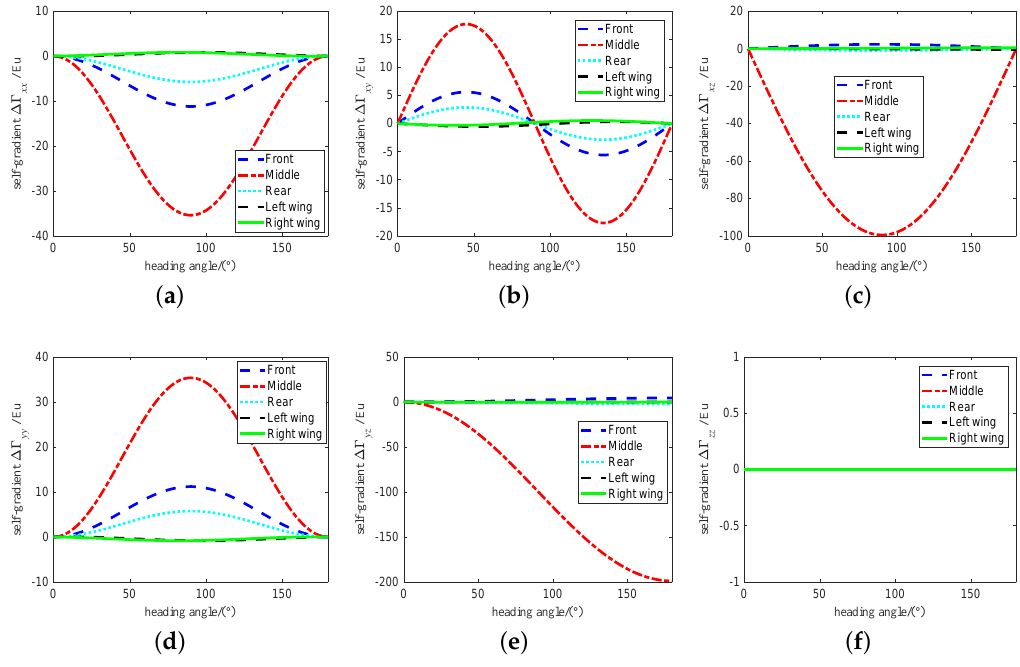
Figure 4. Self-gradient caused by the distribution mass of the carrier in heading attitude. ( a ) Self-gradient element Γ xx . ( b ) Self-gradient element Γ xy . ( c ) Self-gradient element Γ xz . ( d ) Self-gradient element Γ yy . ( e ) Self-gradient element Γ yz . ( f ) Self-gradient element Γ zz